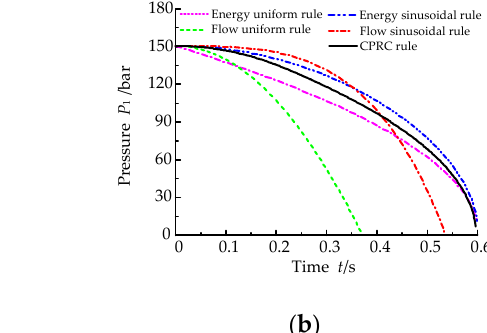
Figure 9. The simulation curve under the different pressure-relief rules under initial pressures of 150 bar. ( a ) Eccentric magnitude curve; ( b ) Pressure-relief curves.